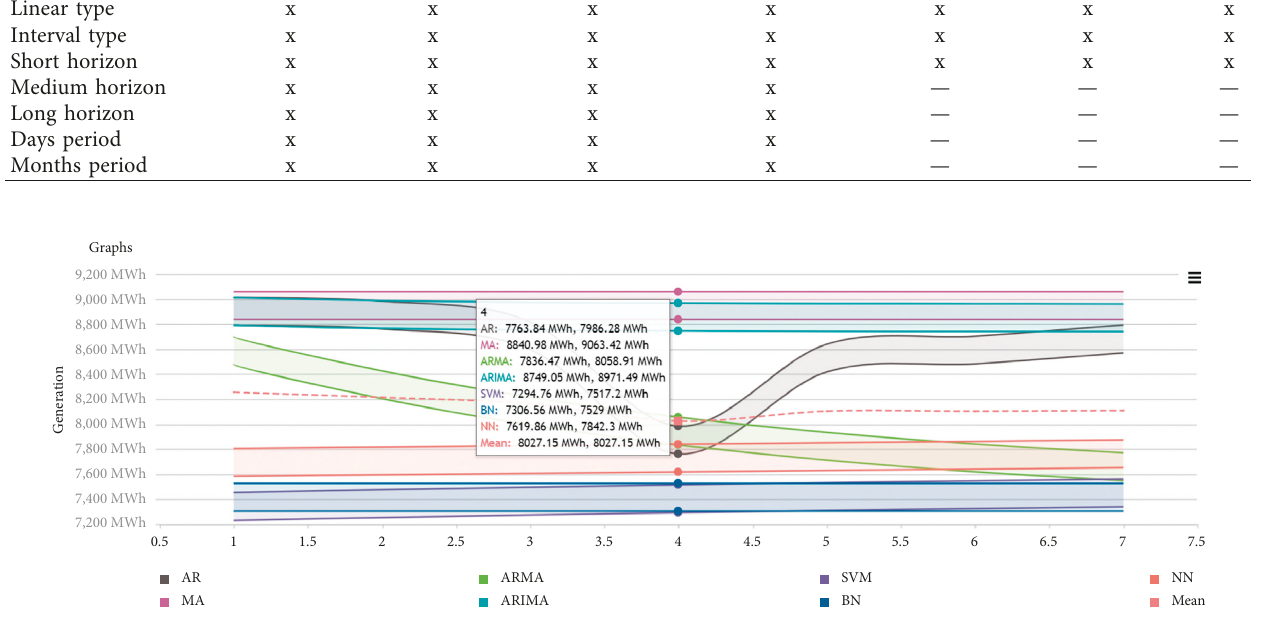
Figure 5: Interval plot for a short-term time horizon.